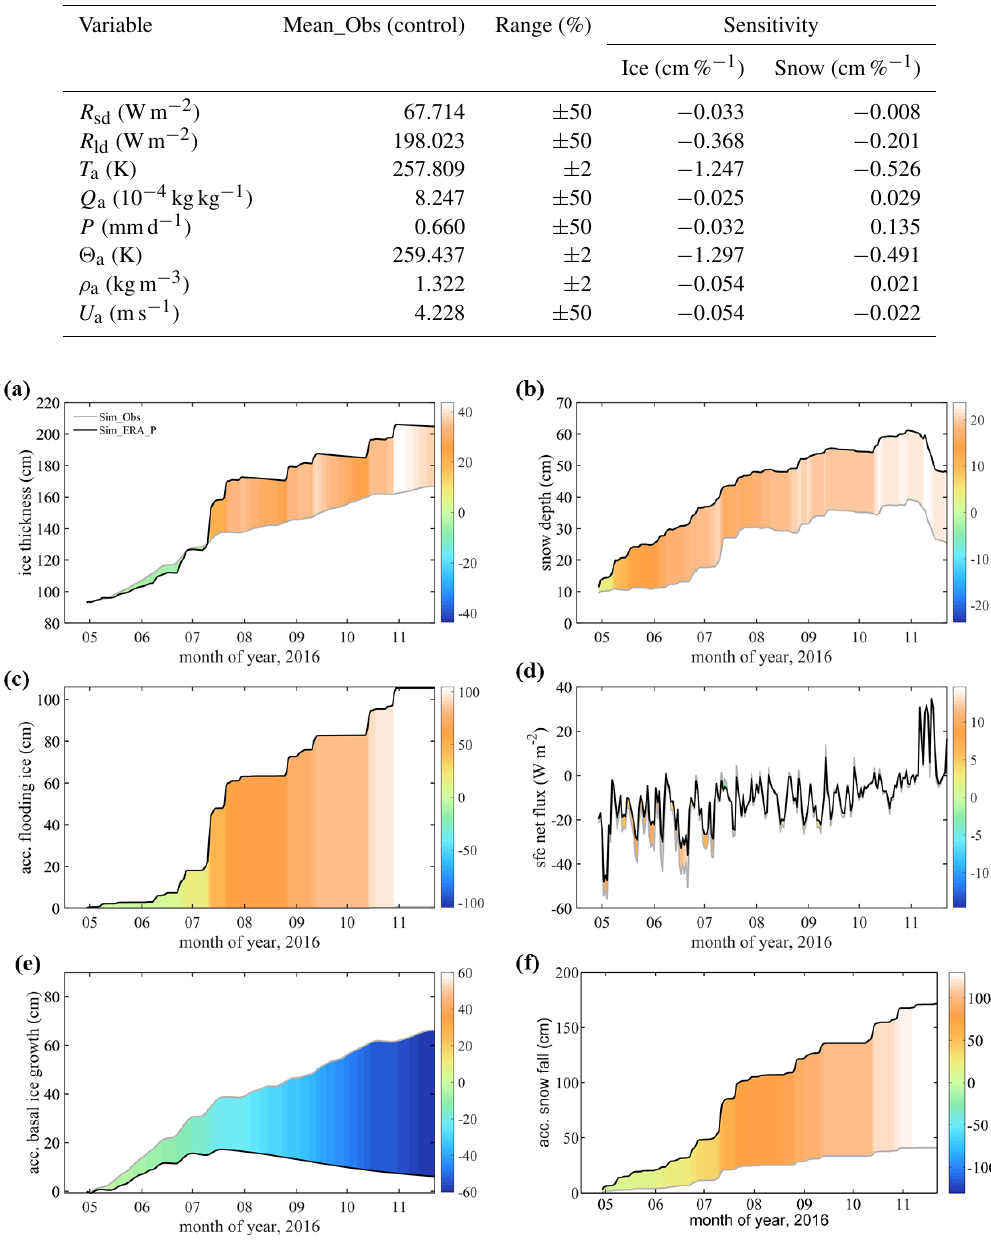
Table 4. The atmospheric forcing (Mean_Obs for the control run and Range for the sensitive run) and sensitivity from SEN2.